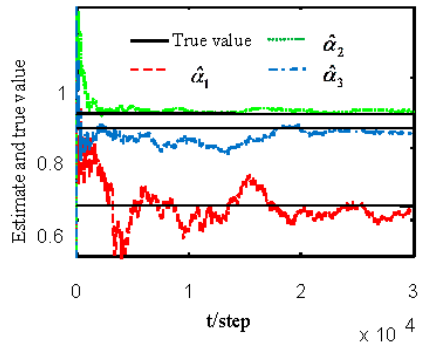
Figure 7. Identification of unknown packet receiving rates α i .